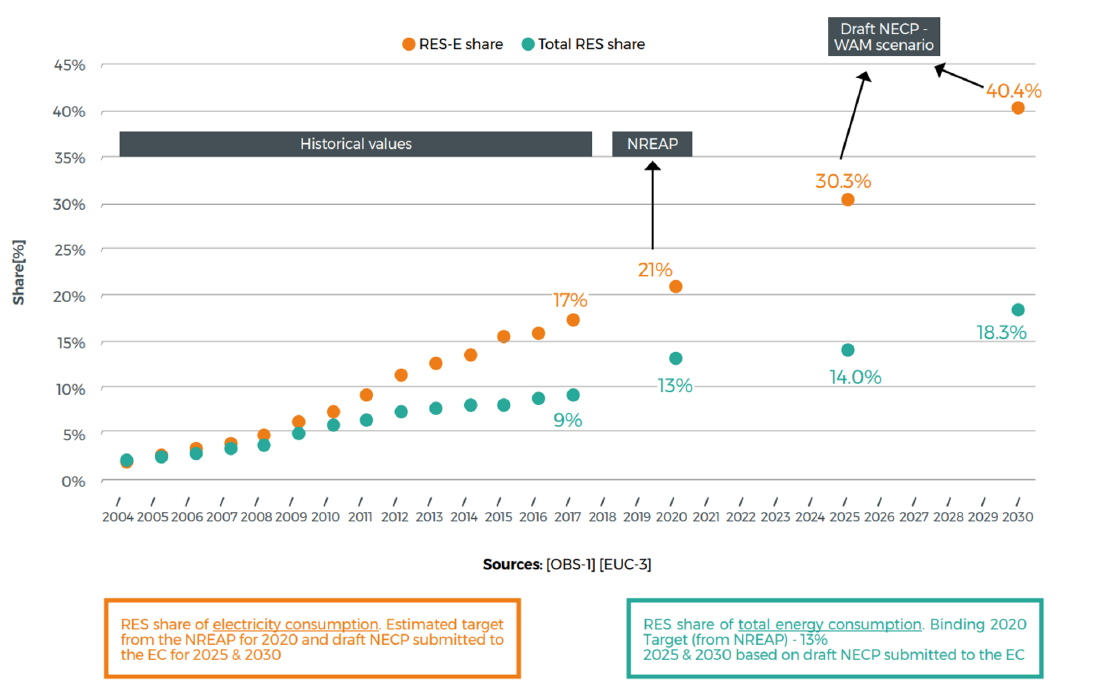
Figure 22. Historical and predicted RES share in electricity and energy consumption in Belgium [153].